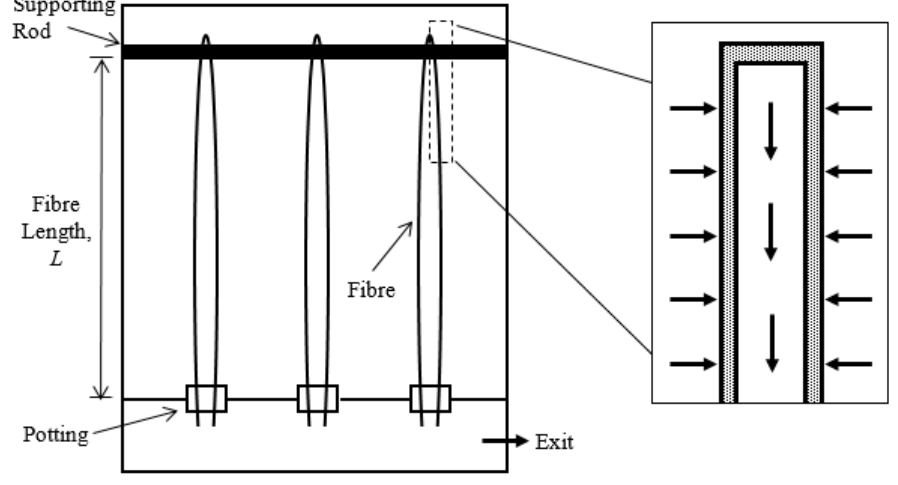
Figure 1. Simplified illustration of fibre layout within housing (single-end configuration). Arrows indicate flow of water within system.